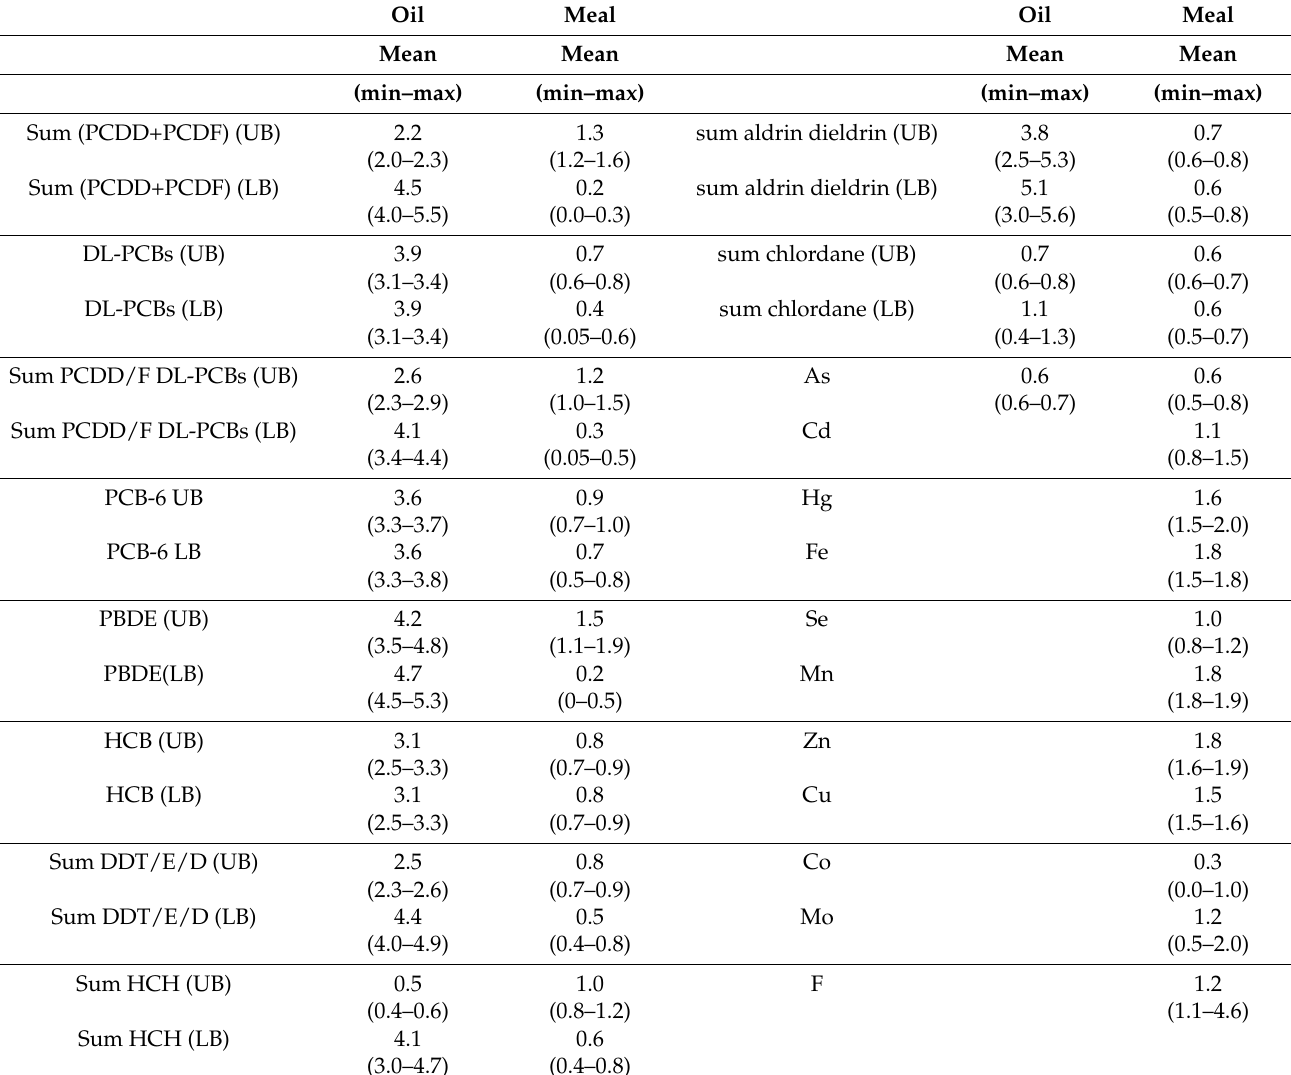
Table 5. Processing factors (ratio of wet weight-based contaminant concentrations in raw mesopelagic biomass to produced oil or meal on dry weight (DW) basis) of dioxins (PCDD/F), dioxin-like PCBs (DL-PCBs) (WHO-TEQ pg g − 1 DW), polybrominated diphenyl ether mixtures (PBDEs), organochlorine pesticides, and the elements arsenic (As), cadmium (Cd), mercury (Hg), and lead (Pb) (mean, minimum–maximum, n = 4) showing up-concentration or dilution during